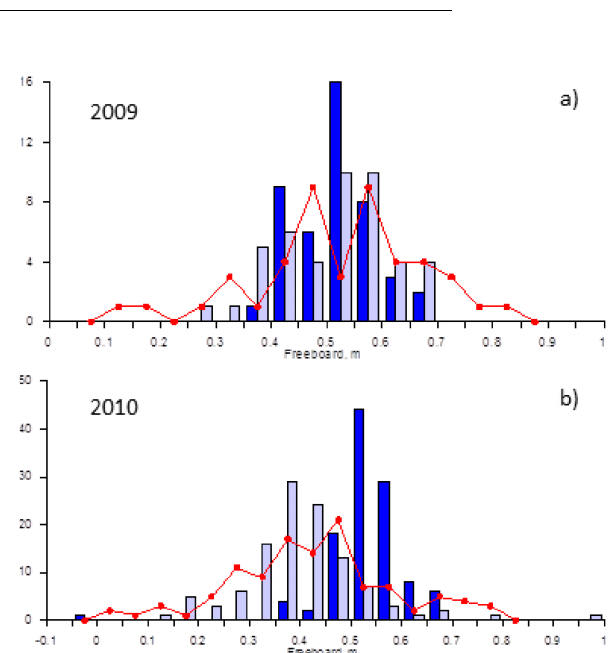
Figure 5. Histograms of OIB (red lines) and RA-2 (blue bars) free- board for OIB data from the Arctic Ocean for 2009 (a) and 2010 (b) . RA-2 freeboard is derived using OIB snow depth (light blue bars) and W99 snow depth (dark blue bars). Both MYI and FYI data are included. Note the different y axis ranges for the number of data per freeboard